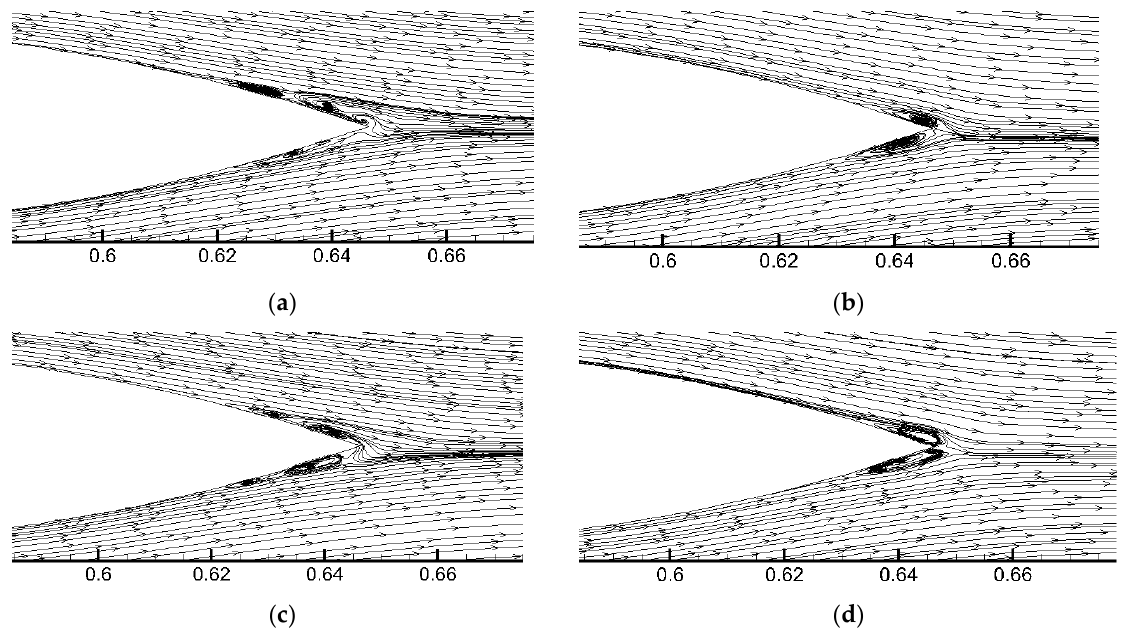
Figure 11. The streamlines at the trailing edge of the two models at different times. ( a ) T = 0.3125 s in the original model; ( b ) T = 0.3125 s in the model with leading-edge serrations; ( c ) T = 1.25 s in the original model; ( d ) T = 1.25 s in the model with leading-edge serrations.